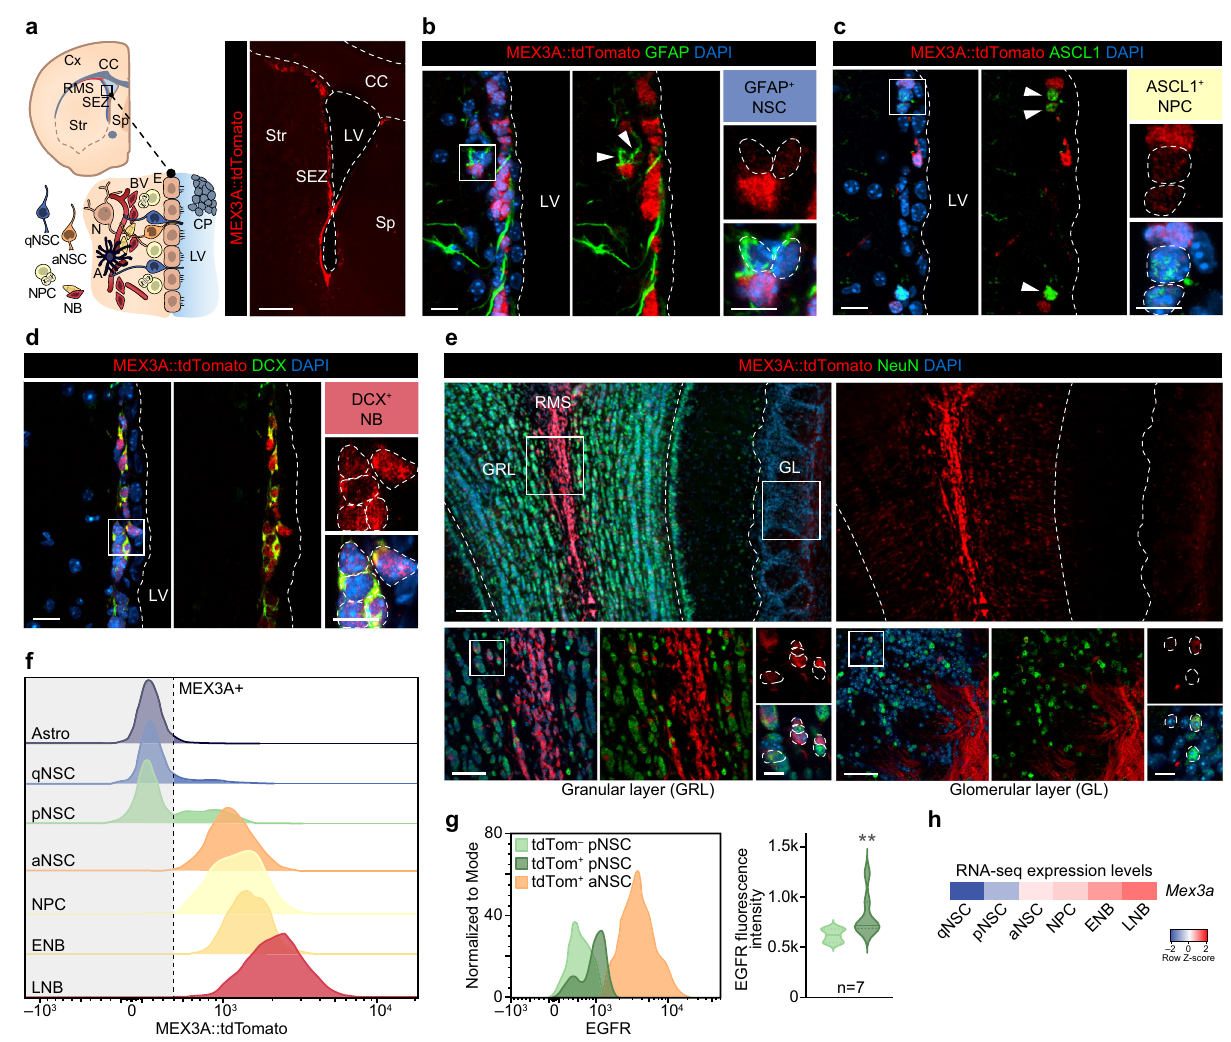
Fig.2|RNA-bindingproteinMEX3AasapotentialregulatorattheonsetofSEZ lineage activation. a Schematic drawing of a coronal brain section displaying the SEZ niche cytoarchitecture (left panel). Immunohistochemistry showing expres- sion of MEX3A::tdTomato (red) in a panoramic image of the adult Mex3a +/KI SEZ (right panel). b Immunohistochemistry showing expression of MEX3A::tdTomato (red) in GFAP + (green) NSCs. c Immunohistochemistry showing expression of MEX3A::tdTomato (red) in ASCL1 + (green) NPCs. d Immunohistochemistry for MEX3A::tdTomato (red) in DCX + (green) NBs. e Panoramic view of a coronal immunostained section of the OB showing expression of MEX3A::tdTomato (red) and NeuN (green, mature neurons) (top panel). High-magni fi cation images of MEX3A::tdTomato expression (red) among NeuN + neurons (green) in the granular (GRL) and the glomerular (GL) layers (bottom panels). f Representative FACS his- tograms showing MEX3A::tdTomato expression among SEZ populations.